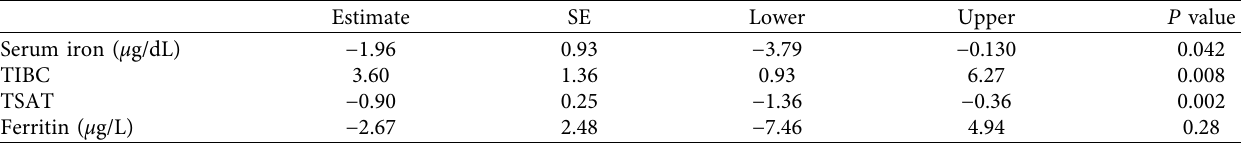
Table 7: Linear regression analysis between iron marker and body mass index.